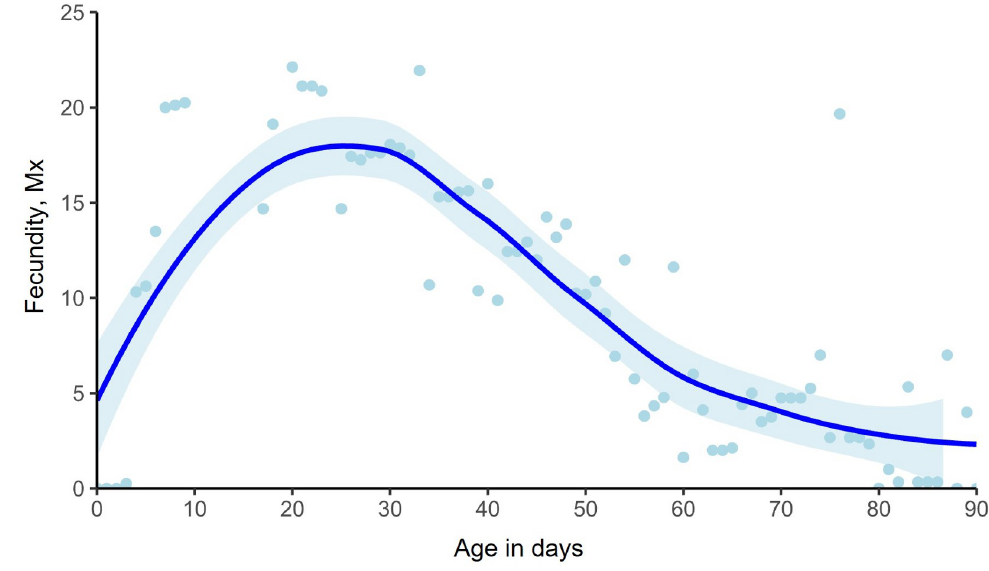
Fig 3. LOESS curves (Locally Estimated Scatterplot Smoothing curves) for age-specific fecundity rates with 95% Confidence Intervals (CI) of females kept in the tubes of LAM25system.